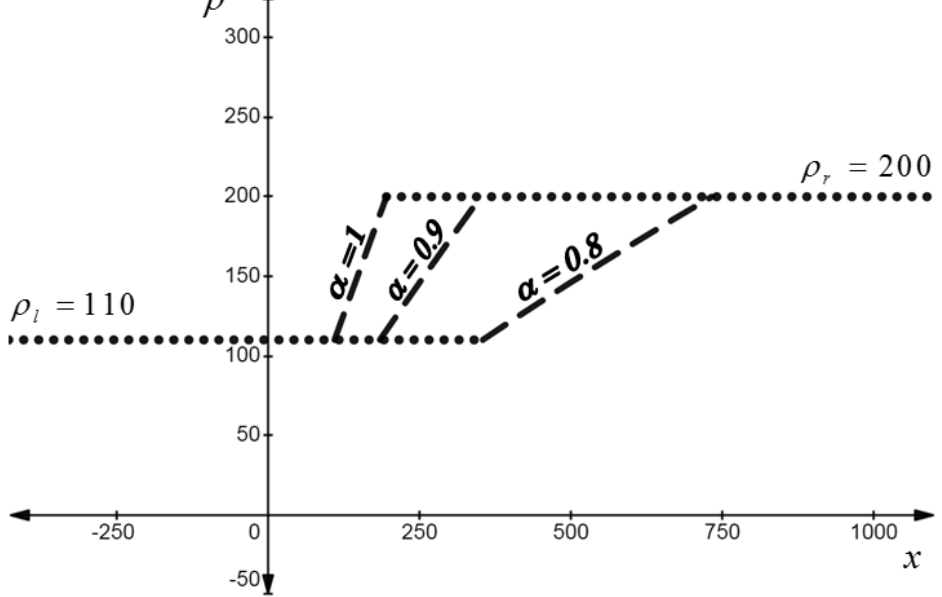
Figure 4. Density in the space. Exact solution at time t = 0.2 hours for different fractional-order values, α = 0.8, α = 0.9, and α = 1.